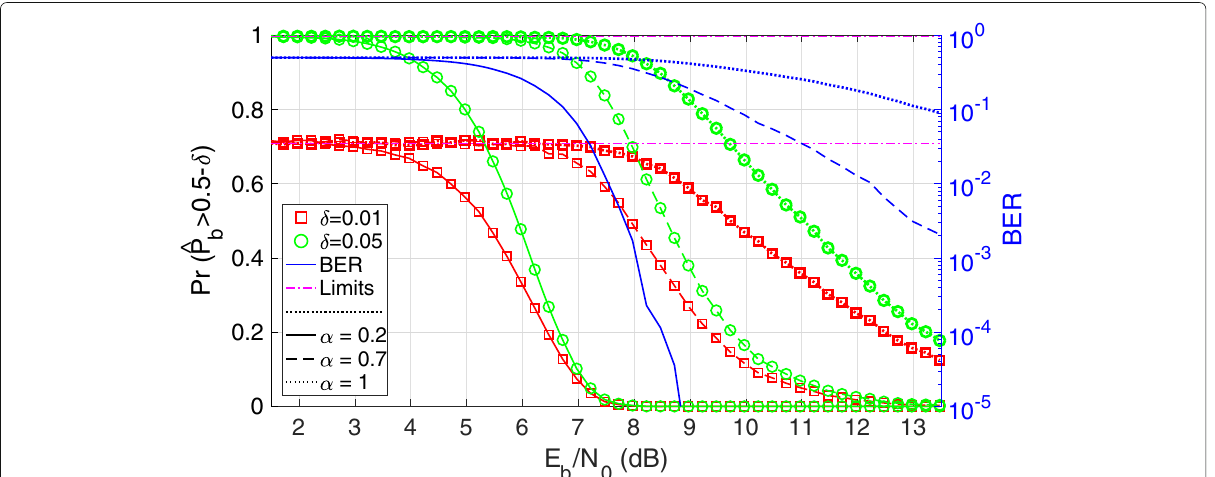
Fig. 7 BER-CDF ac given for two delta values along with the BER. These three curves are given for three different effective jamming powers and show that if Eve experiences jamming power α E = 0.7, then her BER over 753 message bits is guaranteed to be within δ = 0.05 of 0.5 with high probability as long as her E b / N 0 is no greater than 4.7 dB. This corresponds to an SNR value of approximately 4 dB. The lines marked as limits are the limiting expressions given from (10) for the two different δ values